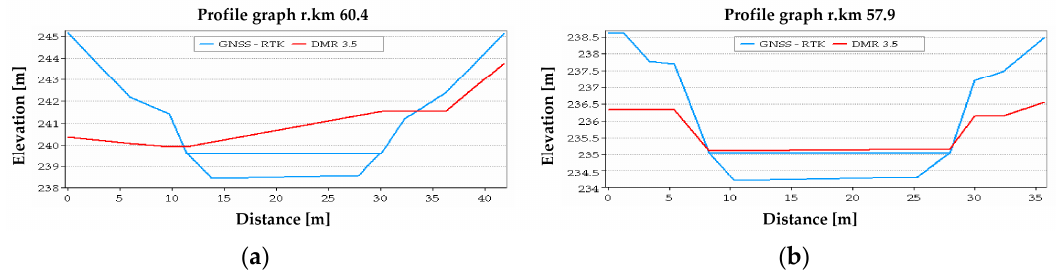
Figure 12. Cross ‐ section of selected part of area for a comparison of height differences. ( a ) river km 60.4; ( b ) river km 57.9. 60.4; ( b ) river km